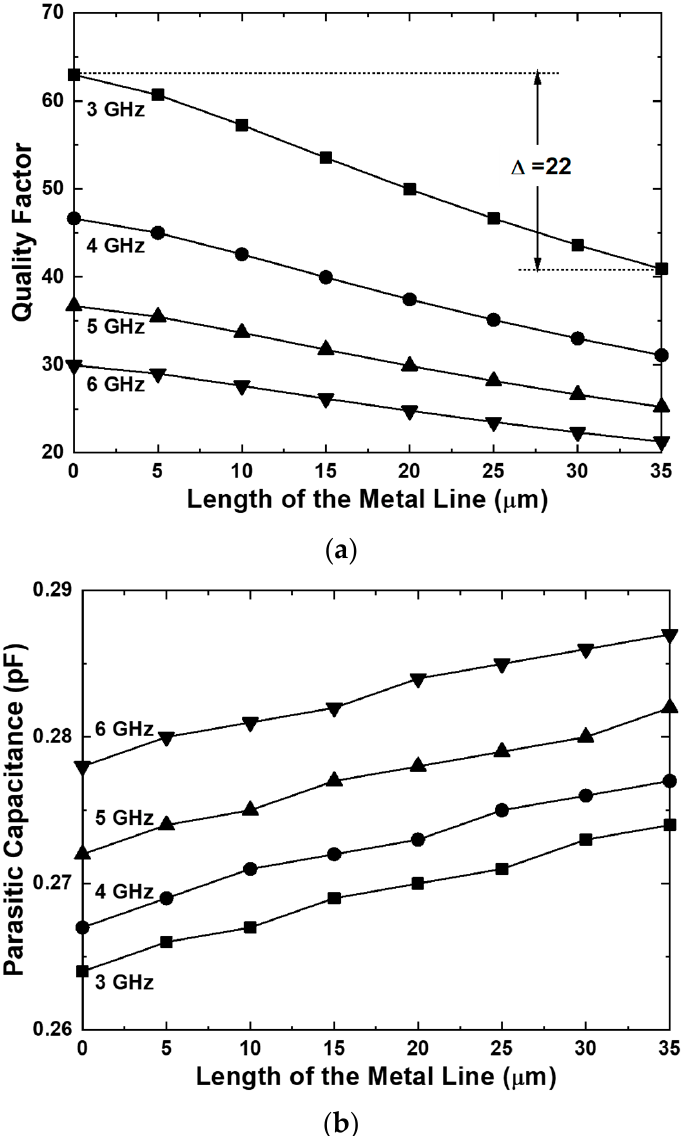
Figure 3. Simulation results of the MOS varactors with zero V CTRL : ( a ) quality factor and ( b ) parasitic capacitance.